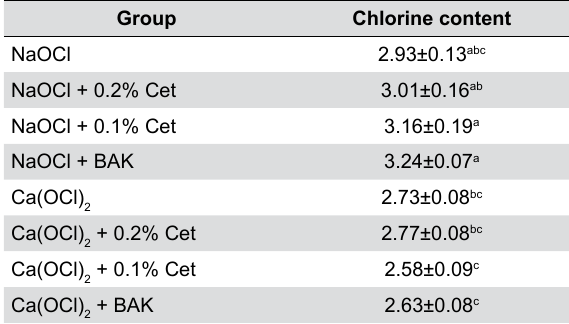
Table 2- Avaliable chlorine content